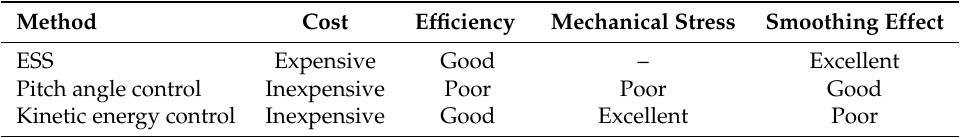
Table 1. Comparison between different smoothing